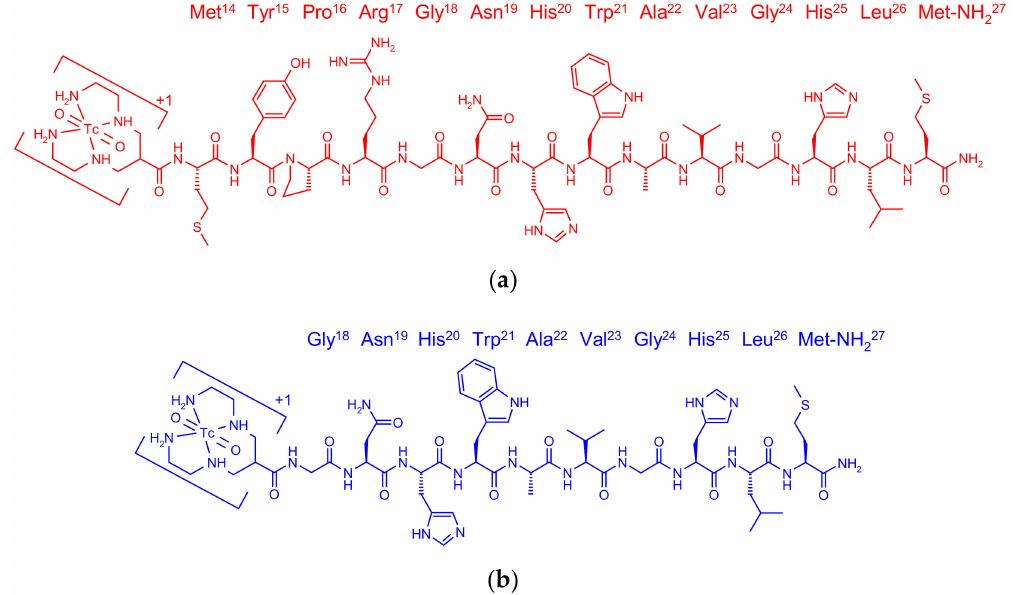
Figure 1. Chemical structure of ( a ) 99m Tc-N 4 -GRP(14–27) (red) and ( b ) 99m Tc-N 4 -GRP(18–27) (blue).